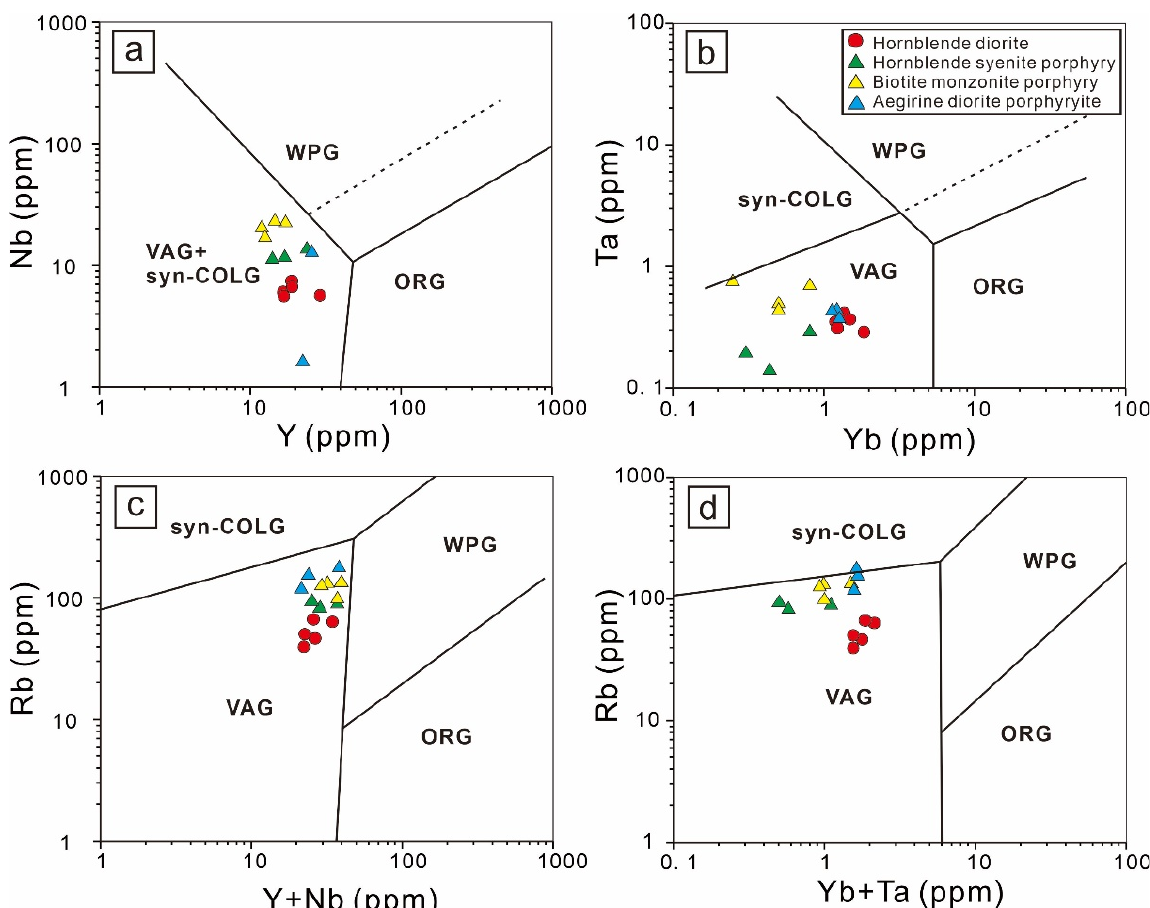
Figure 13. (a – d) Tectonic discrimination diagrams. ( a ) Nb versus Y diagram, modified after [99]. ( b ) Ta diagram and Yb diagram, modified after [99]. ( c ) Rb versus (Y+Nb) diagram, modified after [99]. ( d ) Rb versus (Yb+Ta) diagram, modified after [99]. VAG = volcanic arc granites, Syn-COLG = syn-collisional granites, WPG = within-plate granites, ORG = ocean-ridge granites.